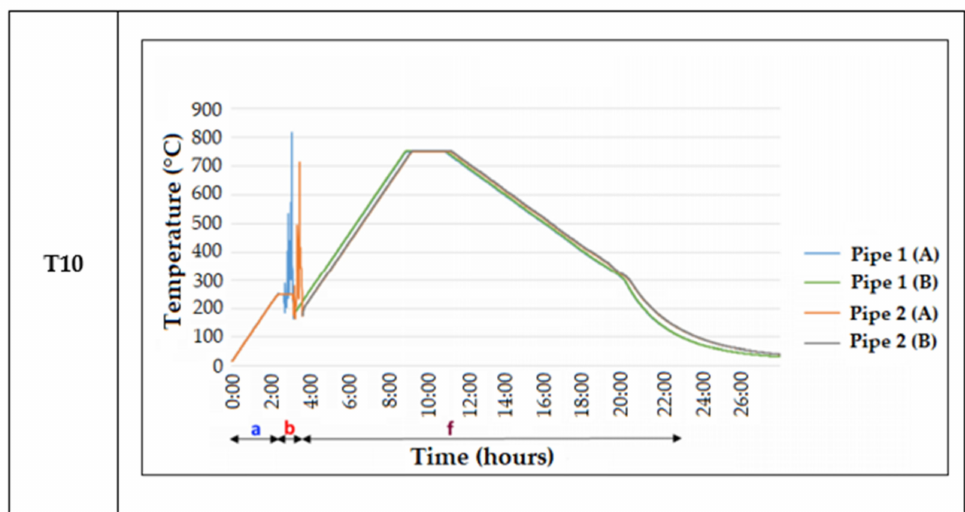
Figure 1. Different sets of thermal cycles used for each sample set, with the various steps identified: ( a ) pre-heating; ( b ) welding; ( c ) post-heating; ( d ) transformation time; ( e ) controlled cooling; ( f ) post-welding heat-treatment (PWHT). Pipe 1 and 2 refers to the material sample name, and A and B refers to the position of the